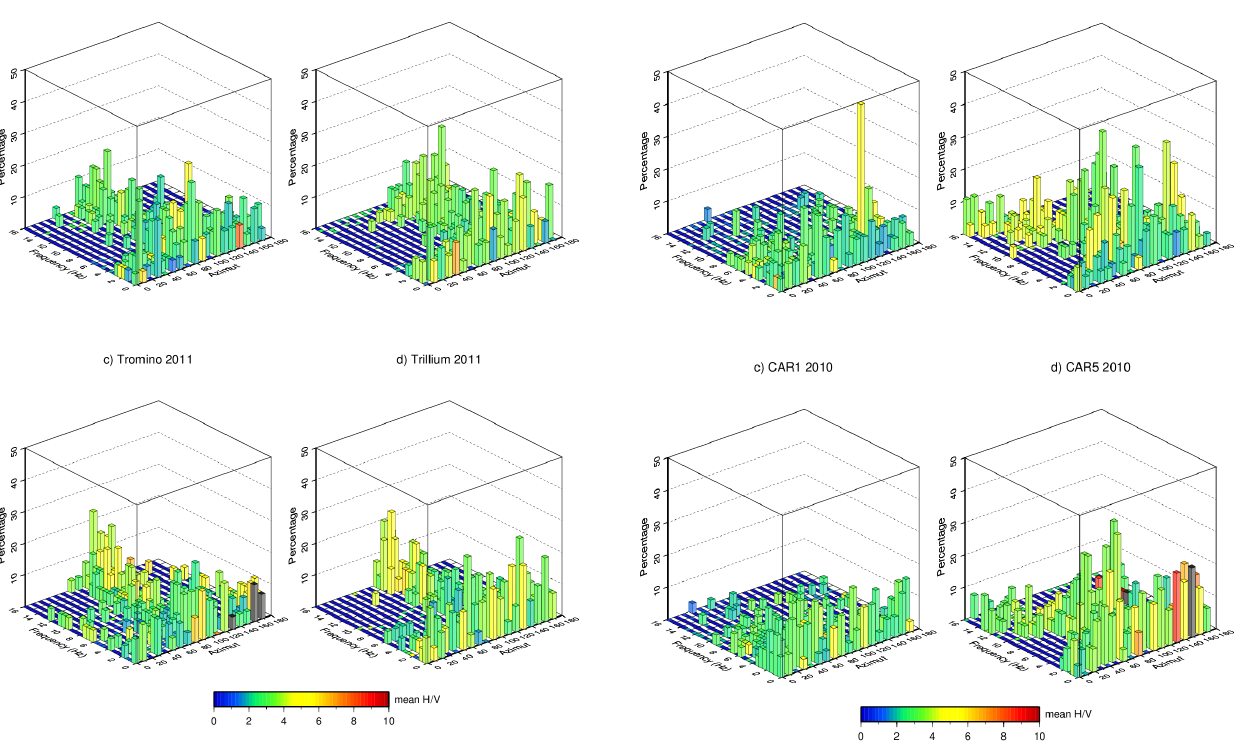
Fig. 5. Histograms of DHVPOR values obtained for noise measure- ments carried out using tomographs in 2007 ( a and b ) and in 2010 Fig. 5 - Histograms of DHVPOR values obtained for noise measurements carried out using 3 ( c and d ) at sites CAR1 and CAR5, tromographs in 2007 (a and b) and in 2010 (c and d) at sites CAR1 and CAR5, respectively. 4